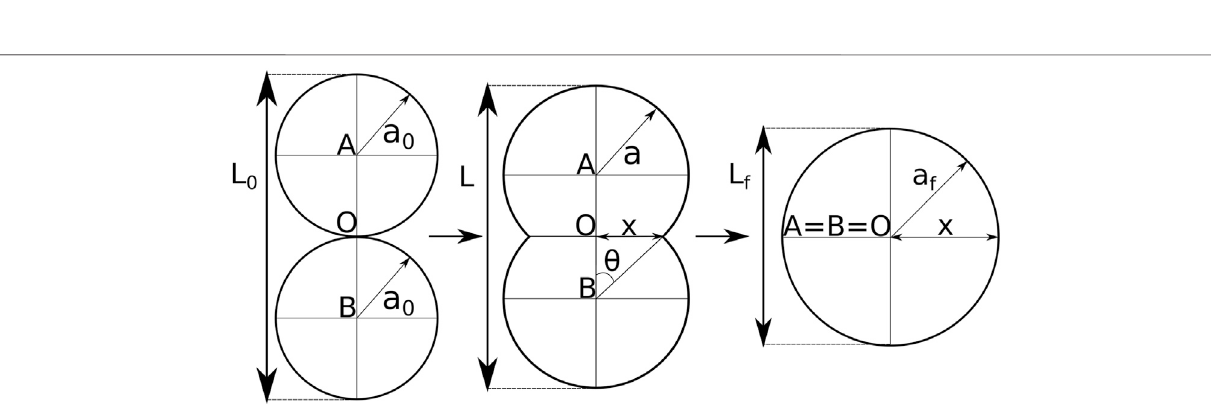
FIGURE2| Shapeevolutionduringspheroidfusionadapted from[3].Theshape isdescribedbytwointersectingcircles withequalradius a ,andcenter A and B . O marks the center of the axis system, and depicts the initial contact point. Based on the intersections one de fi nes the neck radius x and the angle θ . During fusion the centers A and B gradually move toward point O , the radius a increases and the doublet length L decreases. a 0 and a f is the radius of the spheroids before, and after complete fusion, respectively. L 0 and L f is the length of the spheroid doublet before, and after complete fusion,